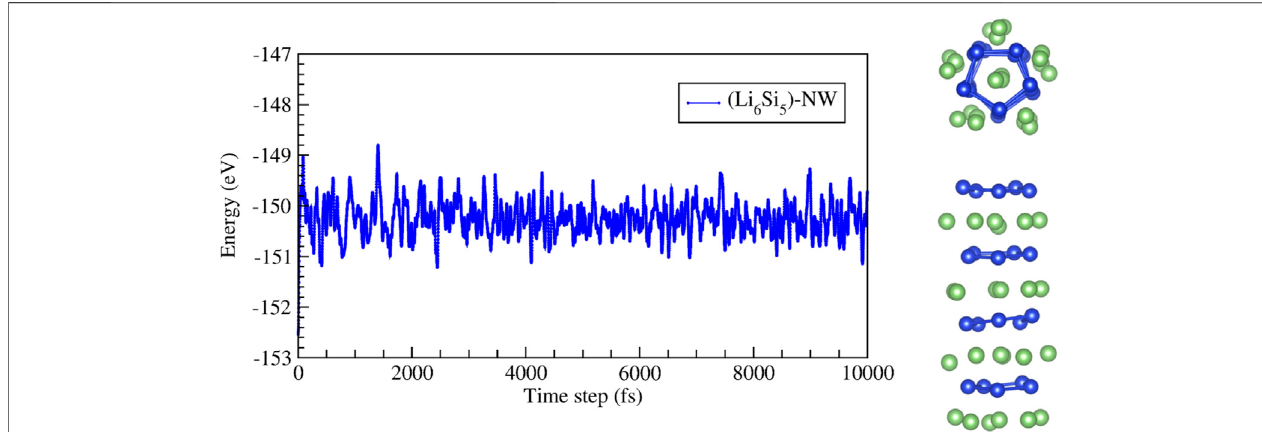
FIGURE4| Energy asafunctionoftimeforthemoleculardynamic simulations at 500 Kofthein fi niteSi 5 Li 6 nanowire. Theunitcellforthissimulationconsidersfour Si 5 Li 6 units. The right images show top and side views of a snapshot taken at 10,000 fs